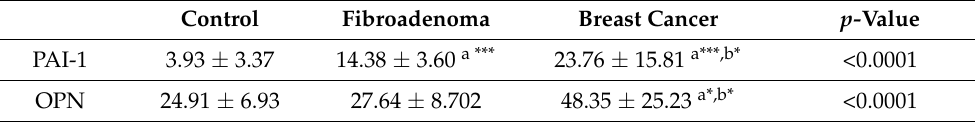
Table 5. Serum levels of PAI-1 and OPN (ng/mL) in the control, the fibroadenoma, and the breast cancer patients.